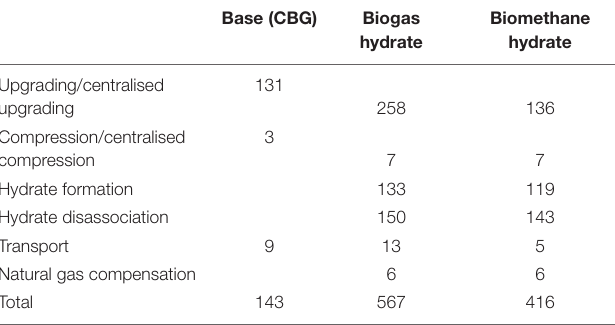
TABLE 5 | Global warming potential (g CO 2 -eq./Nm 3 rawbiogas ) in the three scenarios